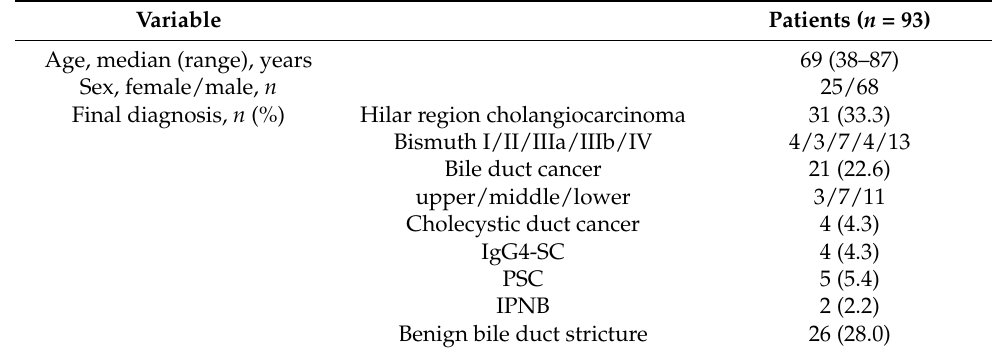
Table 1. Characteristics of patients with indeterminate biliary strictures.